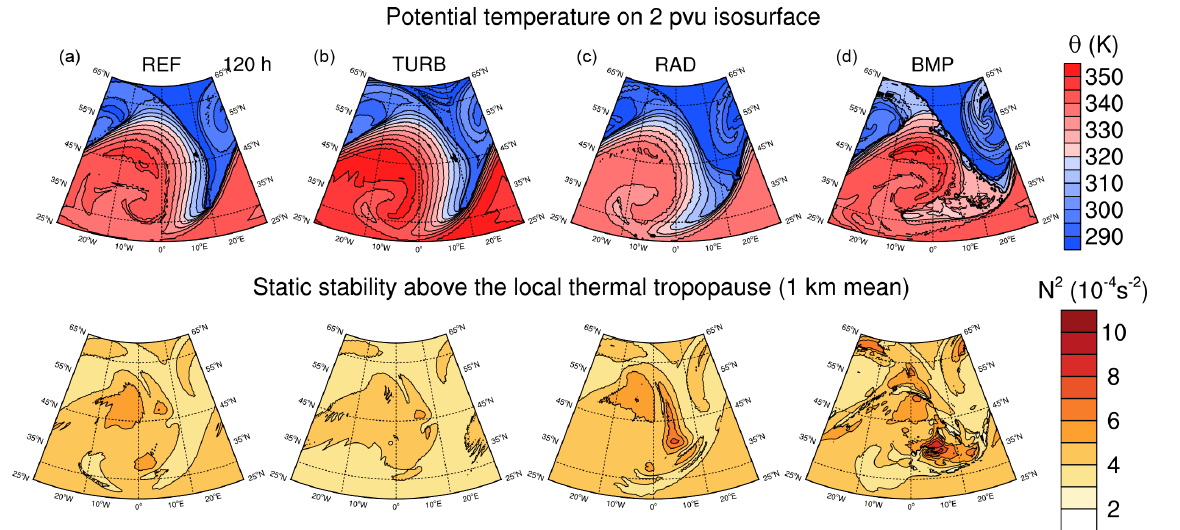
Figure 2. Dynamical and thermodynamical state of the baroclinic life cycles after 120h of model integration. In the upper row the distribution of potential temperature (cid:50) (in K) on the dynamical tropopause is depicted, while the lower row shows the distribution of static stability N 2 (in 10 − 4 s − 2 ) averaged over the first kilometer above the thermal tropopause. The four columns show from left to right the following simulations: (a) REF, (b) TURB, (c) RAD, and (d)